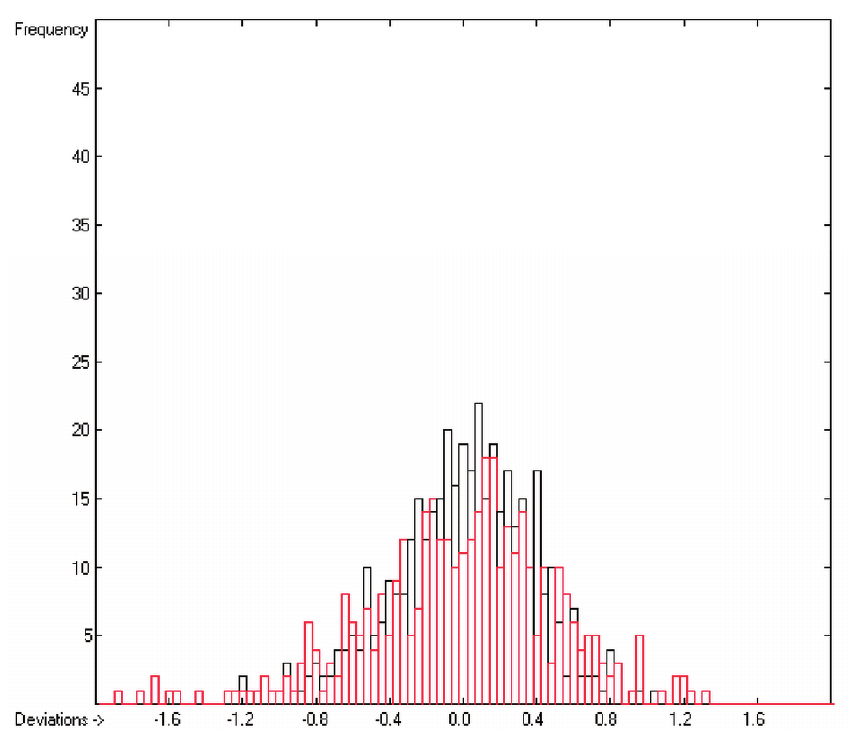
Figure 24. Histogram of logBB data (S =